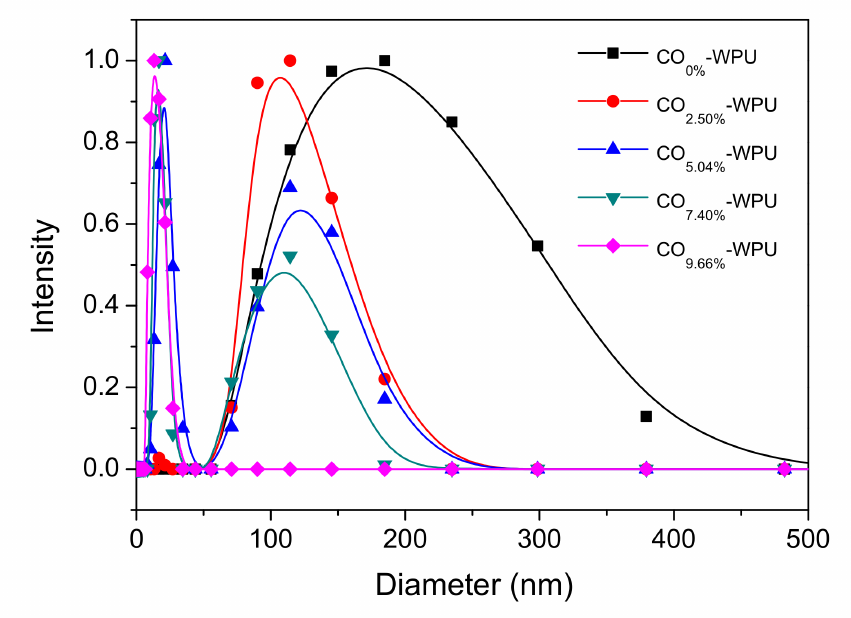
Figure 2. The particle size distribution of